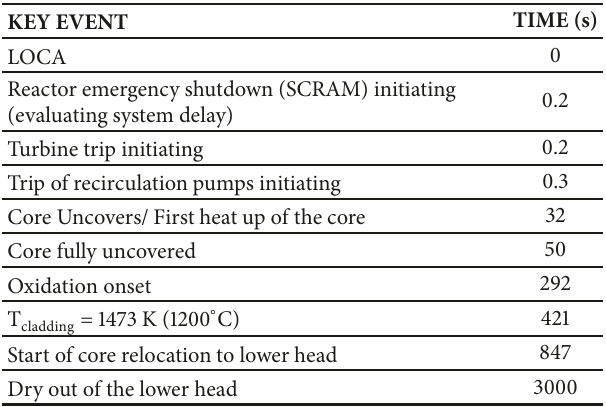
Table 2: Key events of accident